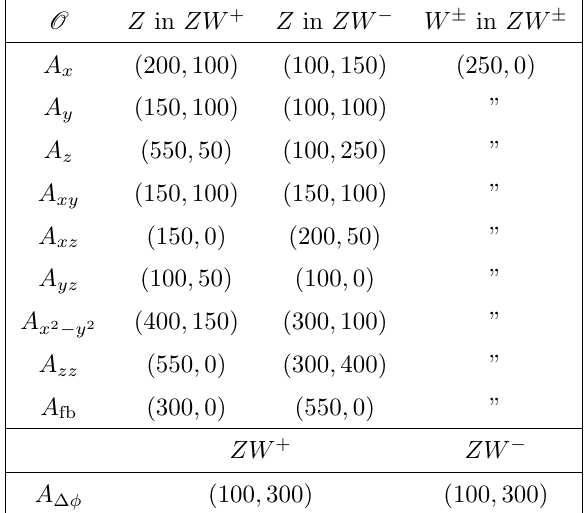
Table 4 . The list of optimized lower cuts ( opt.cut ) in GeV on ( m to maximize their sensitivity to the anomalous couplings.